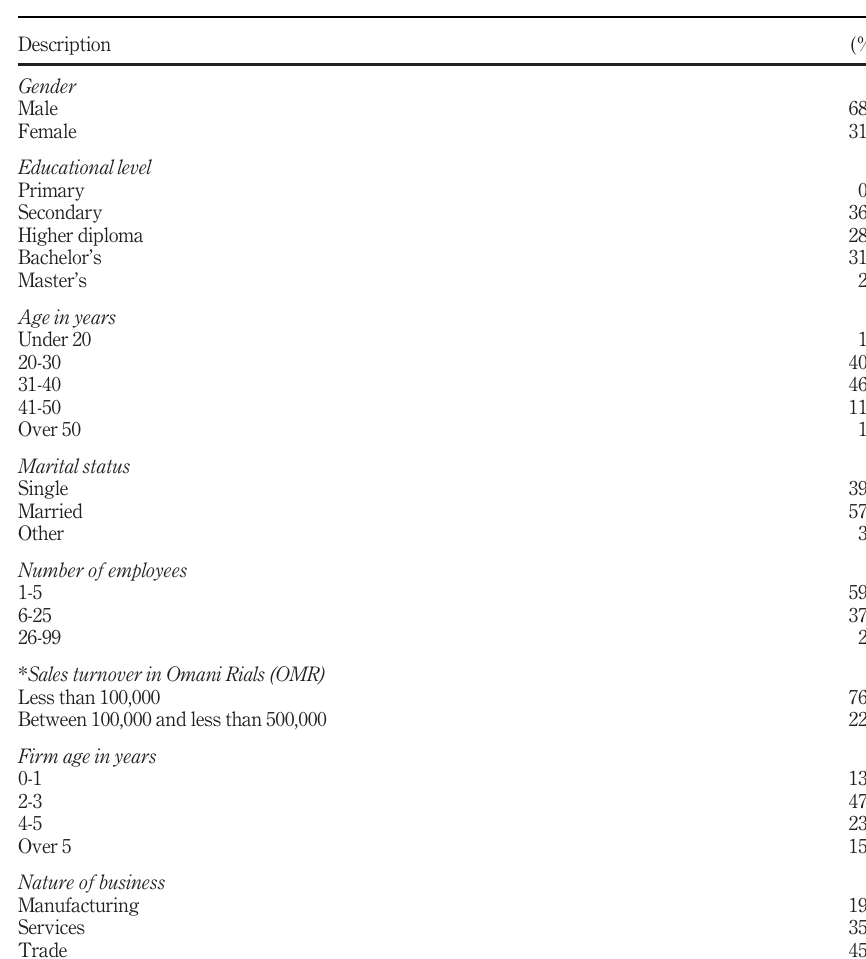
Table II details the descriptive statistics of the SME fi rm owners and their fi rms ’